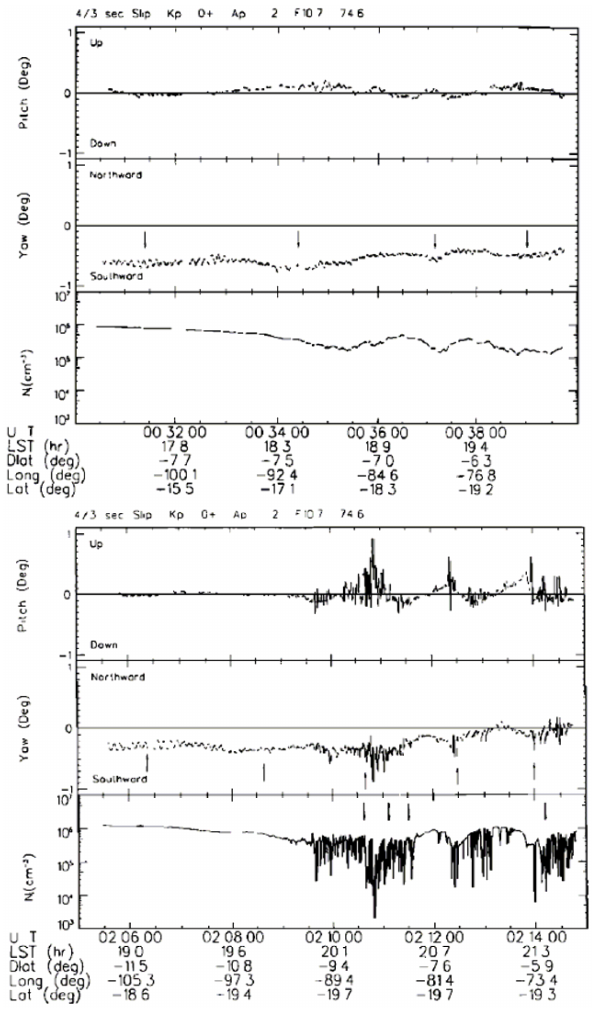
Fig. 11. Ion drift data and electron density plots taken during two consecutive orbits (7192 and 7193), almost retracing one another. The large scale fluctuations are very similar. The first orbit (top panel) shows undulations, attributed to gravity waves by the au- thors, that become unstable and break into large structured bubbles in the second orbit (after Singh et al., 1997).